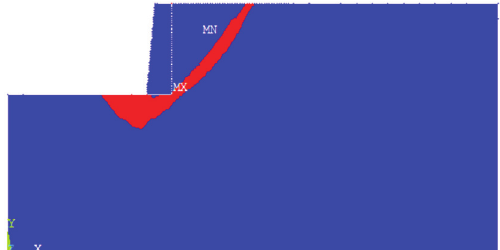
Figure 7: Contour of ultimate strain.